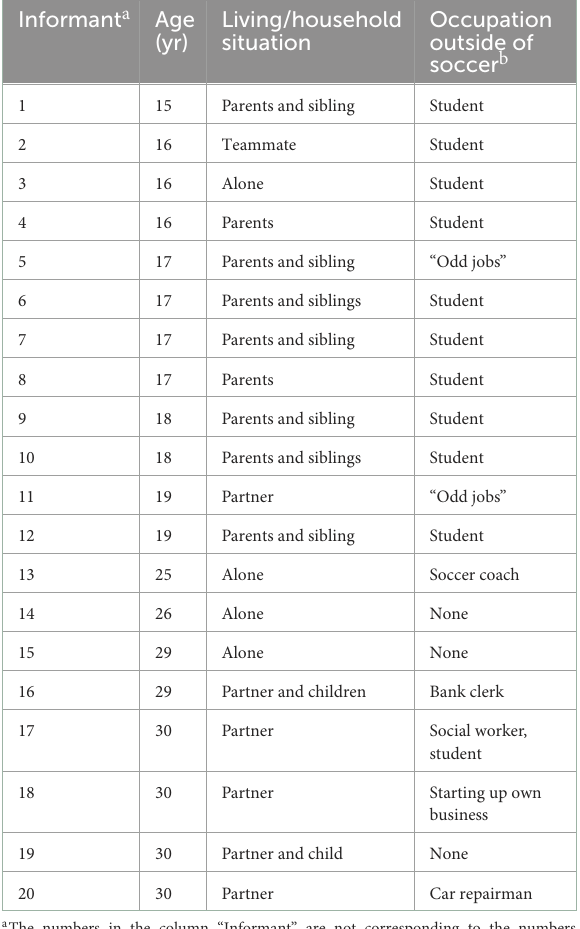
TABLE 1 Background information of the